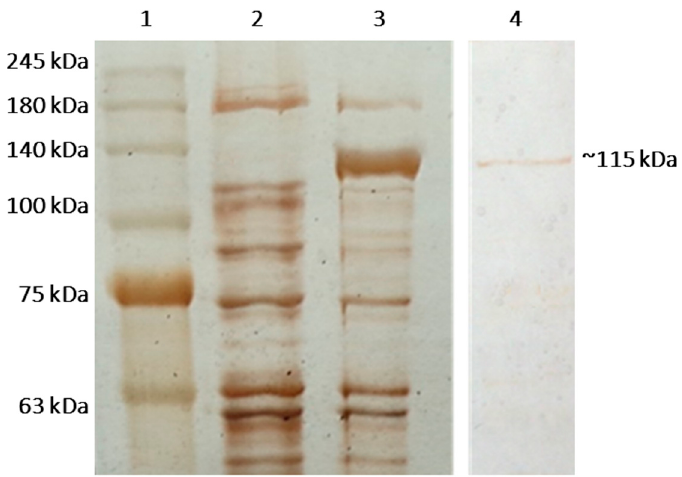
Figure 5. Overexpression and purification of recombinant β -galactosidase of L. bulgaricus 43 in E. coli BL21(DE3), demonstrated by SDS-PAGE in 10% separating gel after silver staining. Legend: (1) Perfect TM Tricolor Protein Ladder; (2) crude extract of the cells of untransformed E. coli BL21(DE3) as control; (3) crude extract from E. coli BL21(DE3) cells, bearing pET-41- β -gal and induced with 1 mM IPTG for 24 h; (4) the purified enzyme β